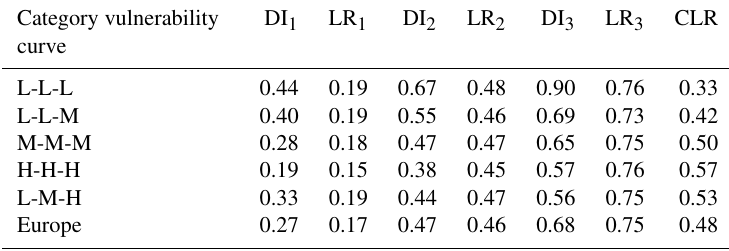
Table B1. Classification key points and cumulative loss rates calculated by category vulnerability curves.